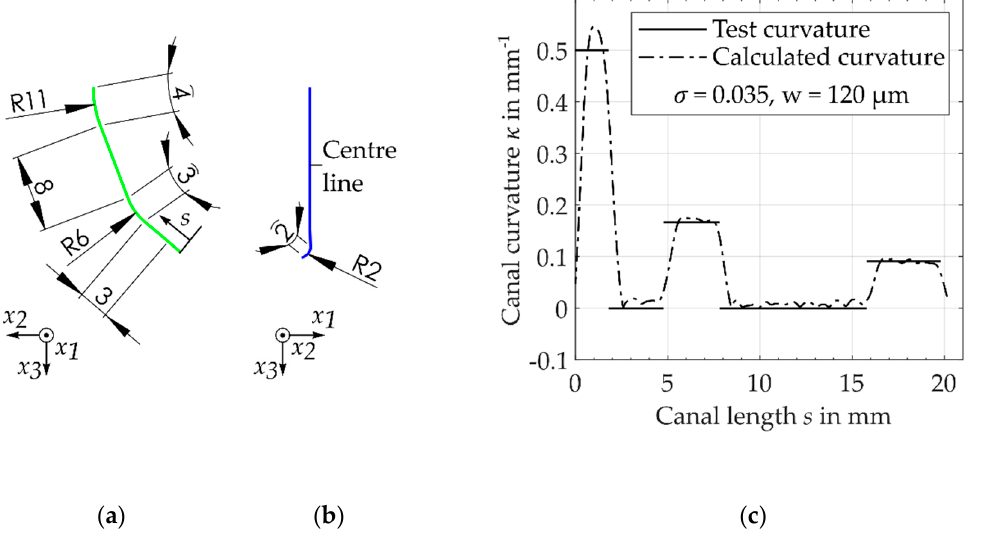
Figure 4. Centre line of a defined artificial root canal: ( a ) buccolingual view, ( b ) mesiodistal view, ( c ) result of developed algorithm and the defined canal curvature of the defined test case.